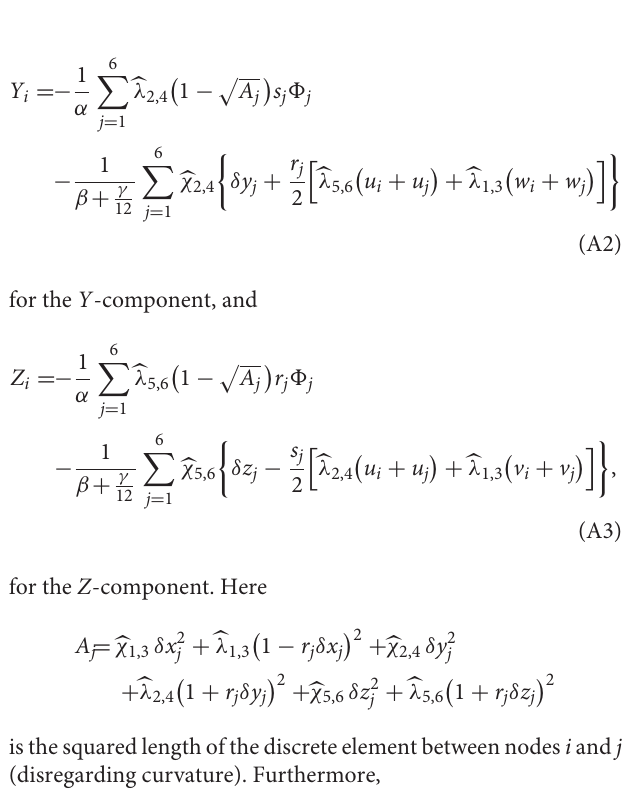
FIGURE A1 | The end of a square beam deformed in torsion. The upper surface has been rotated 45 ◦ clockwise and the bottom surface 45 ◦ counter-clockwise. Version based on linear equations is shown on the left, and version based on non-linear equations is shown on the right.